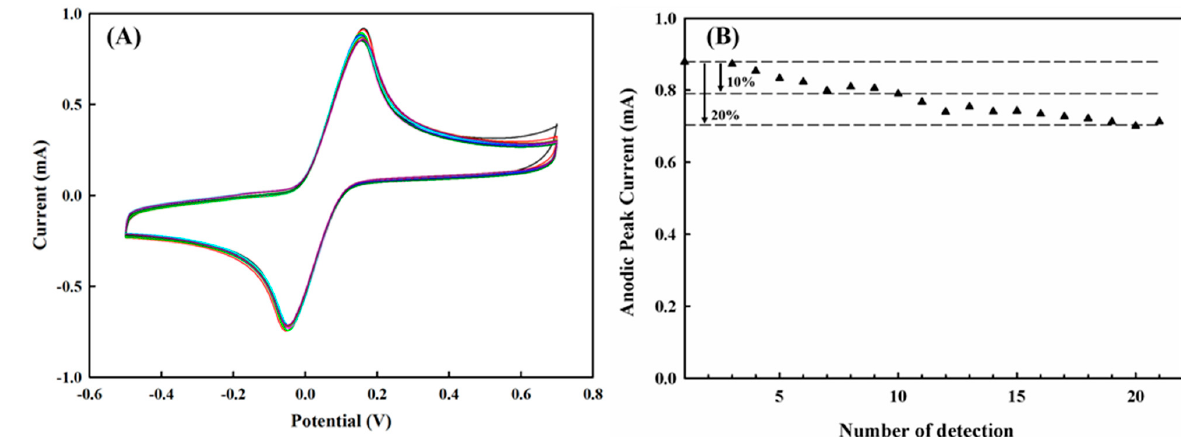
Figure 8. The stability analysis of PEDOT/PL electrode for the detection of 6 mM of hydroquinone in 100 mM of PBS buffer. The potential was swept from − 0.5–0.7 V with the rate of 100 mV s − 1 . ( A ) The cyclic voltammetry profiles for ten individual tests. The same electrode was thoroughly washed with distilled water three times after each test. ( B ) The anodic peak current for each measurement.